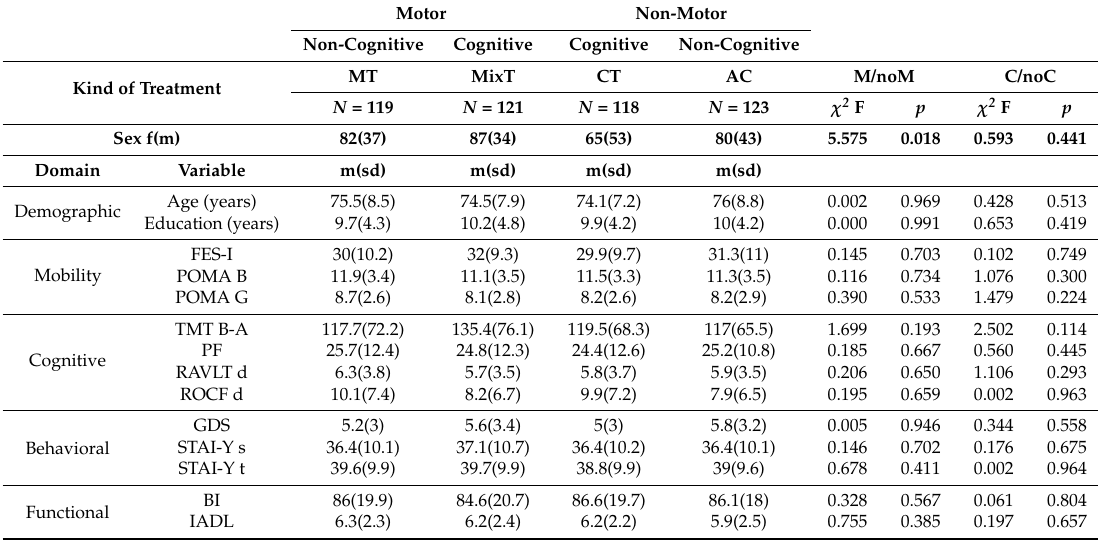
Table 1. Demographics and study outcomes at